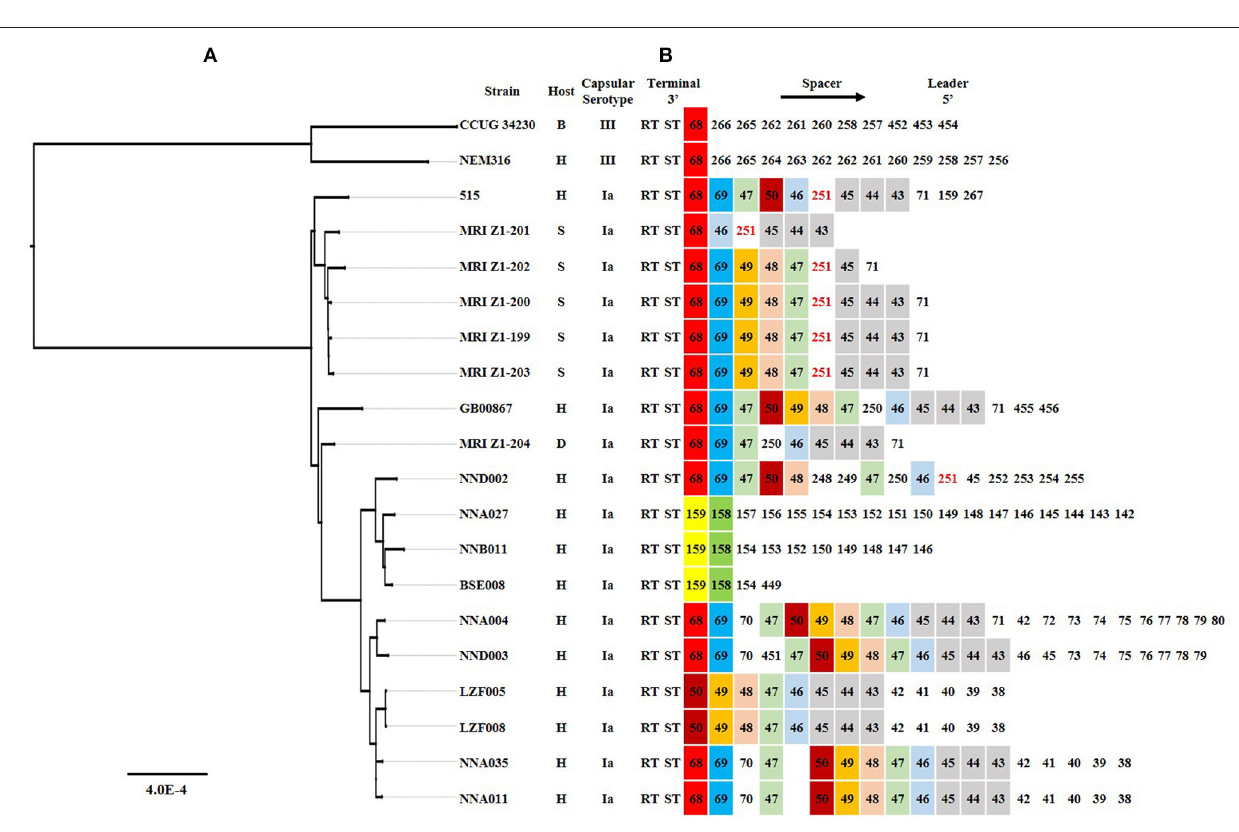
FIGURE 3 | The phylogenetic analysis and CRISPR structure comparison for 20 different ST23 GBS strains. (A) A Maximum Likelihood phylogenetic tree based on 2,154 single copy orthology clusters of the 20 strains. (B) CRISPR loci comparison. Direct repeat sequence was not included; only RT, ST and spacers were represented. The spacer was numbered, and the same number highlighted with same color indicated that the spacer sequence was the same. H, S, B, and D indicated Human, Seal, Bovine, and Dog,